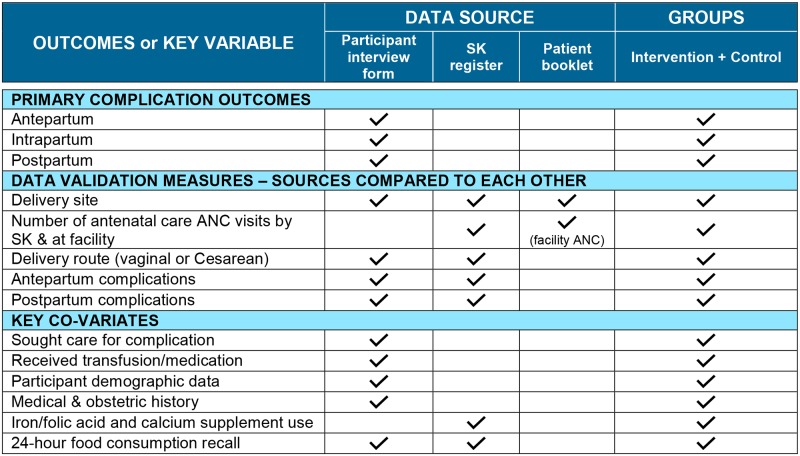
Data sources used for primary outcomes and key variables among postpartum women, in 4 districts of Bangladesh.ANC, antenatal care; SK, Shasthya Kormi.